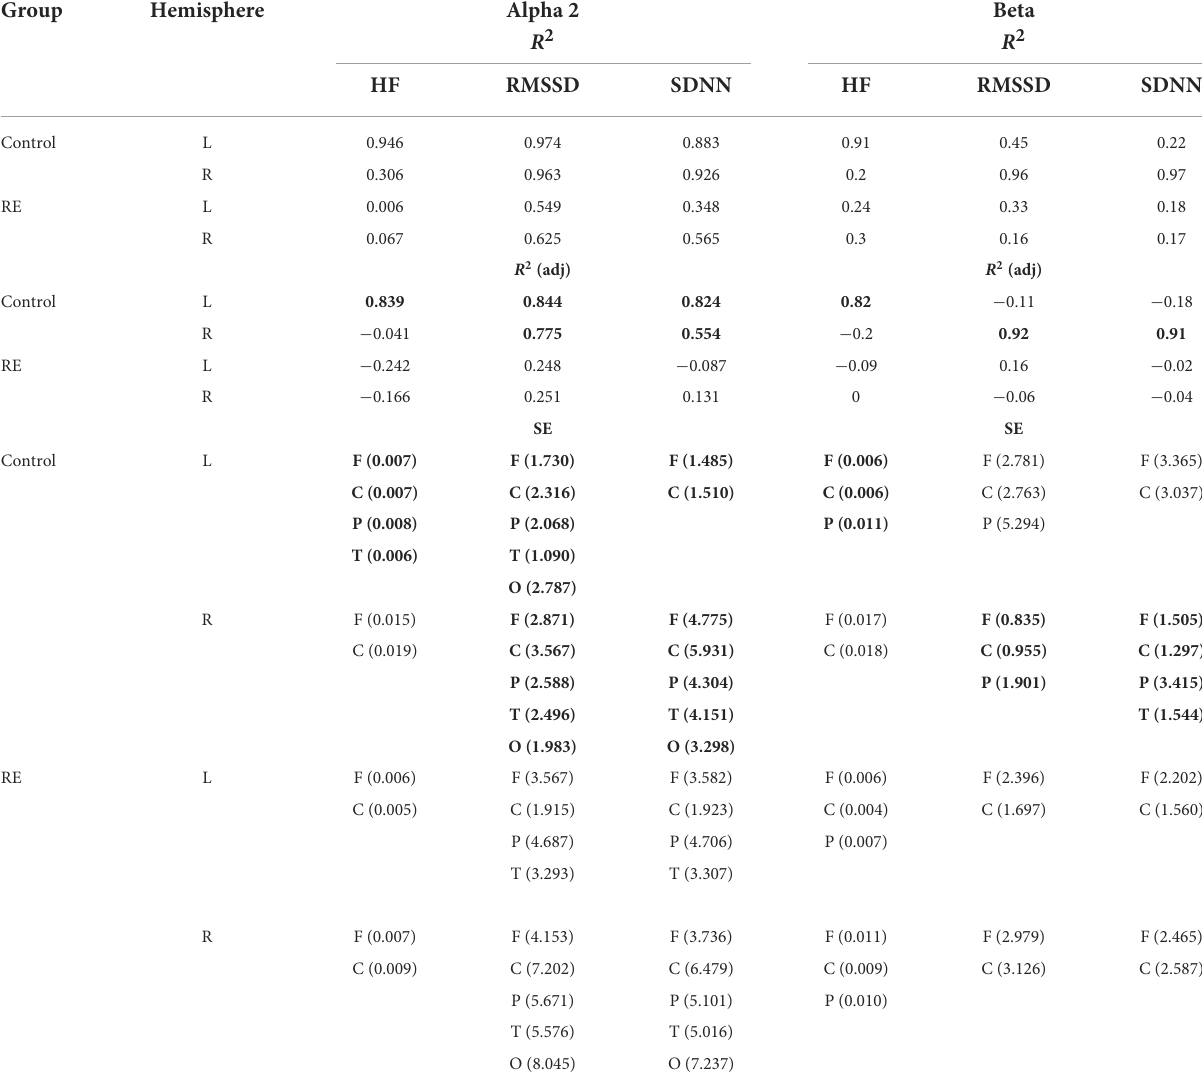
TABLE 5 Multiple regression parameters for HRV variables as a function of EEG power (alpha 2 and beta).